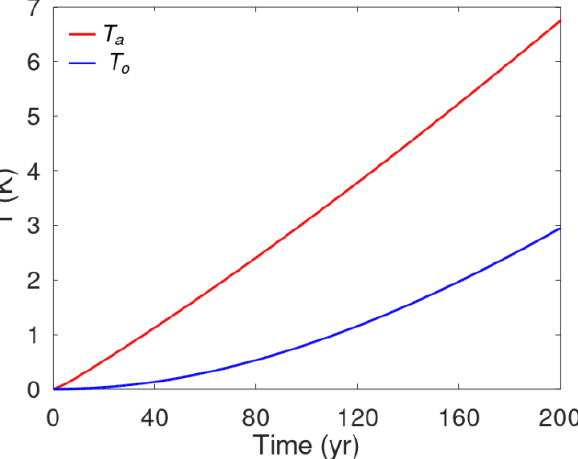
Figure 5. Global mean surface temperature (red line) and global mean deep ocean temperature (blue line) calculated for linear forcing.